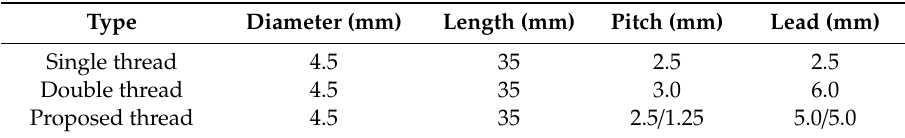
Table 1. Detailed dimensions of the tested screws.